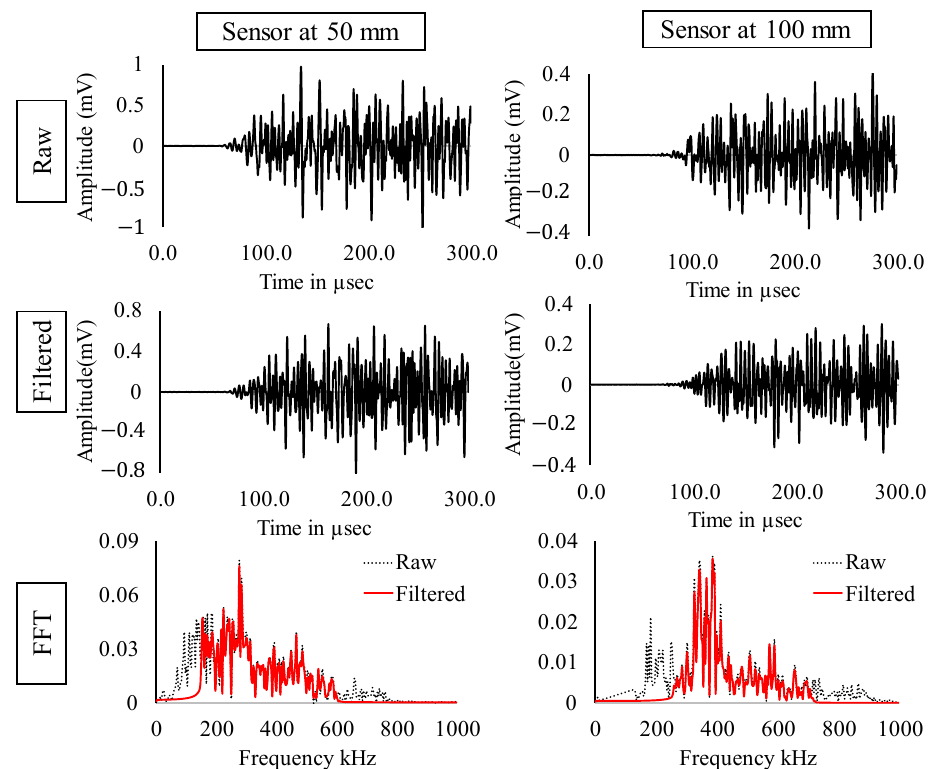
Figure 14. Raw, filtered and FFT of AE signals occurring at load = 150 kN.